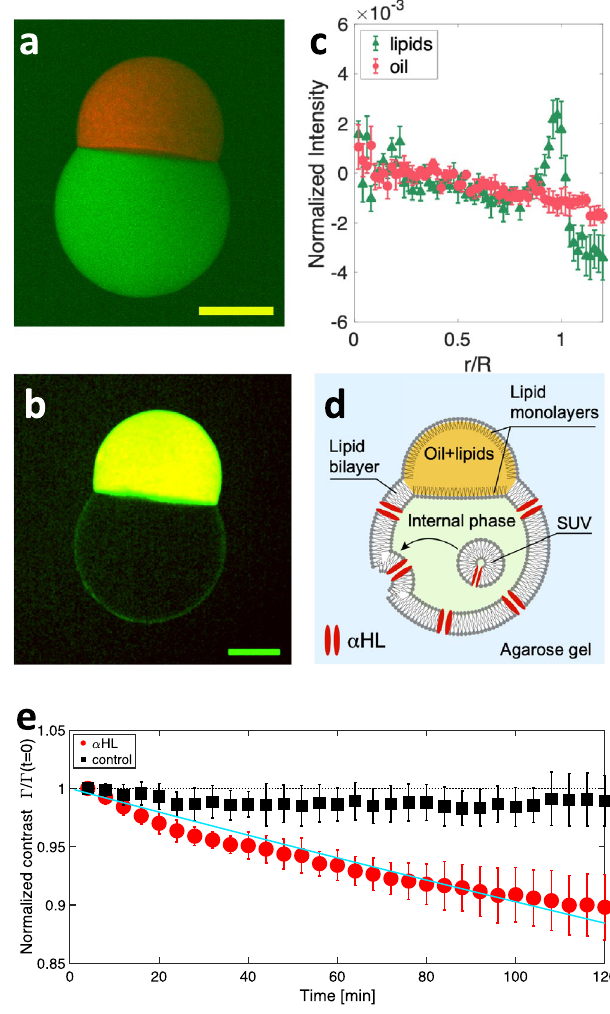
Figure 2. ( a ) Composite confocal microscopy image of a pseudo-vesicle trapped in an agarose gel. The internal phase contains carboxyfluorescein (green), while the oil phase contains Nile Red (red). ( b ) Composite image obtained by adding 1wt% fluorescent NBD-PC in the lipid mixture (green) and an oil containing Nile Red (red). Yellow color = red + green channels. For clarity, the image has been smoothed with a 2 pixel radius Gaussian filter. Scale bars = 200 µ m. ( c ) Normalized radial fluorescence intensity profile, averaged over N=8 pseudo-vesicles labelled as in ( b ). The green triangles ( resp. red disks) show the fluorescent lipids channel ( resp. fluorescent oil channel). Error bars are SE of data. R = 316 ± 24 µ m is the average pseudo-vesicle size. ( d ) Sketch of α HL insertion in the pseudo-vesicle membrane, using α HL loaded SUV. ( e ) Time evolution of the normalized contrast Ŵ( t )/Ŵ( t = 0 ) , for α HL loaded pseudo-vesicles (red disks, N=5) and control experiments without α HL (black squares, N=5). Error bars are SD of data. The solid line is an exponential fit of the data Ŵ( t )/Ŵ( t = 0 ) = e − t /τ ≈ 1 − t /τ , with τ = 5.9 ± 0.3 .10 4 s